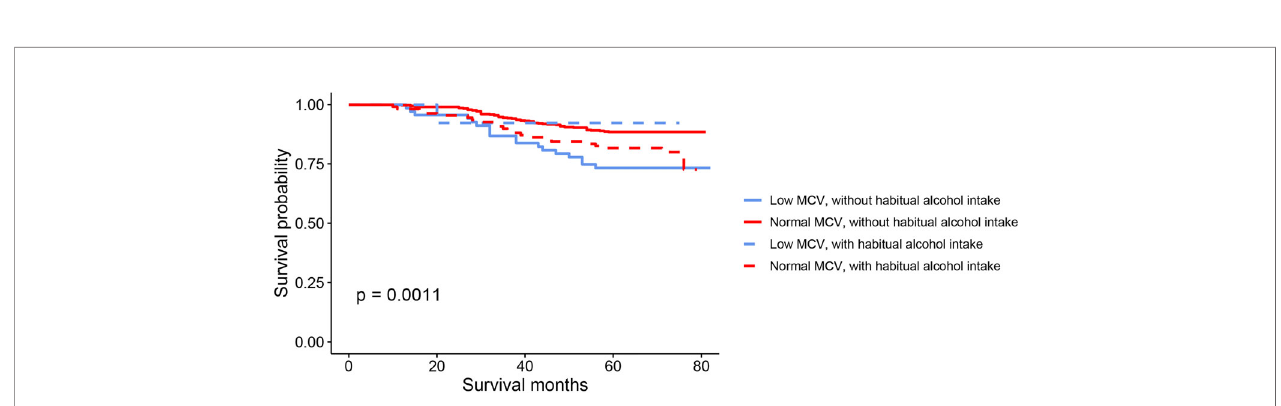
FIGURE 2 | Kaplan – Meier OS curves according to the levels of pretreatment MCV with the implications of habitual alcohol